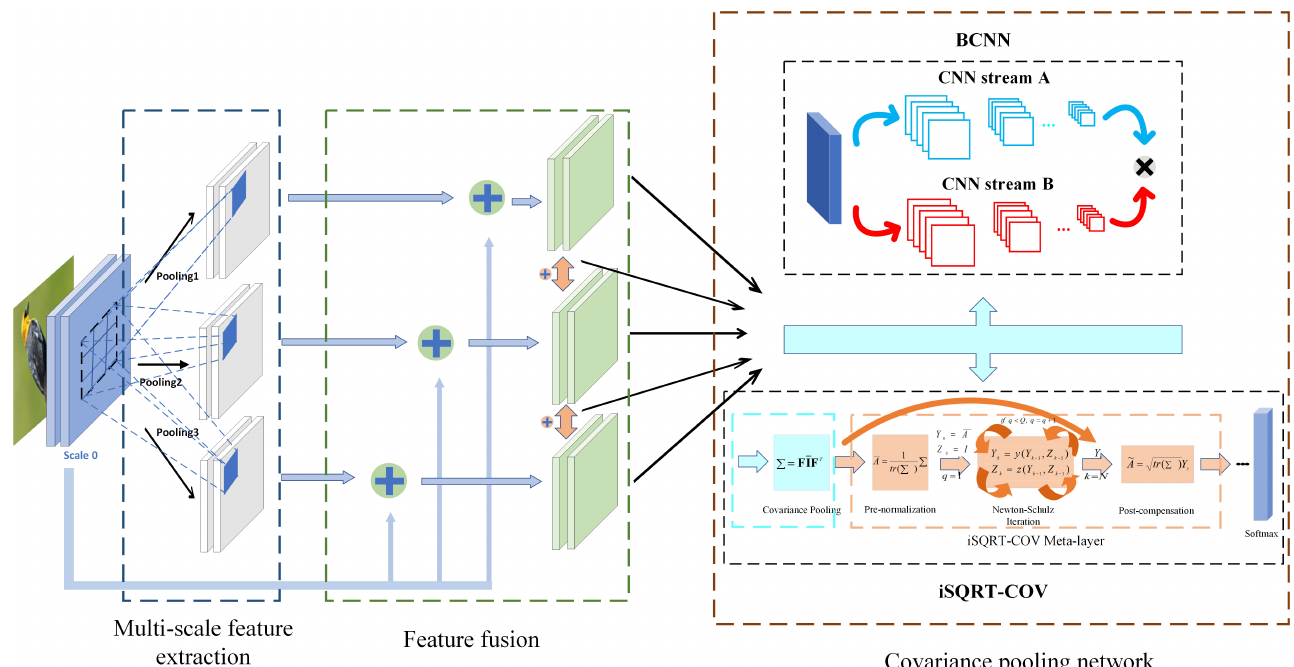
Figure 1. The structure of MSCPN. The feature maps are pooled to generate multiple scales and then fused with the original scales or other generated scales. Finally, they are sent to BCNN and iSQRT-COV. The plus sign in the figure indicates the additive fusion between feature maps. The detailed structures of BCNN and iSQRT-COV are described in Figures 2 and 3.